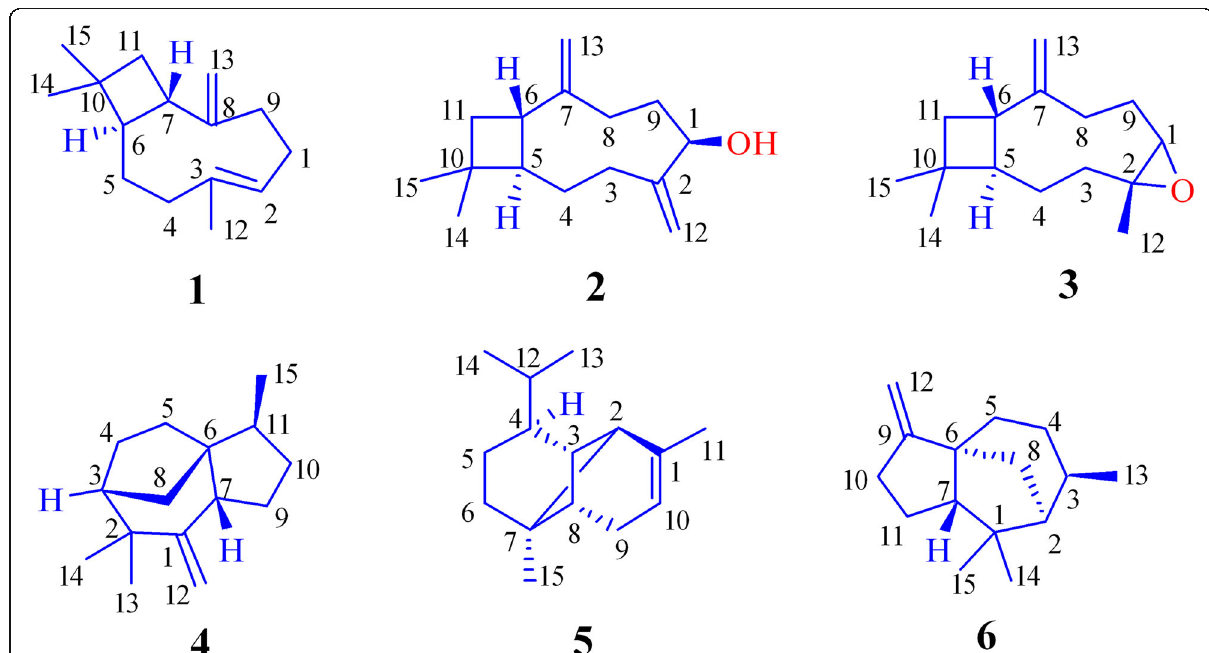
Fig. 1 Known metabolites identified from methanolic extract of Cardiospermum